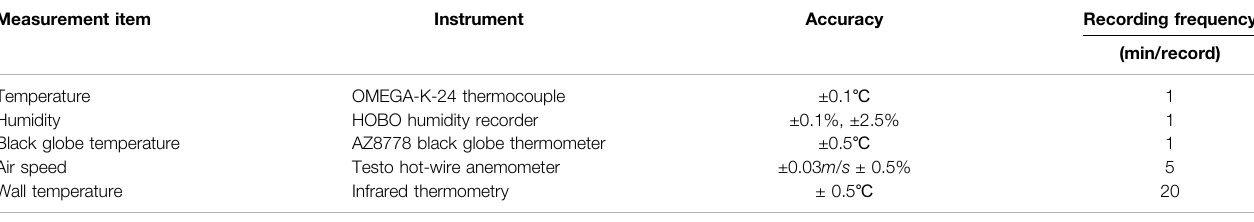
TABLE 1 | Measuring equipment, accuracy, and sampling frequency.